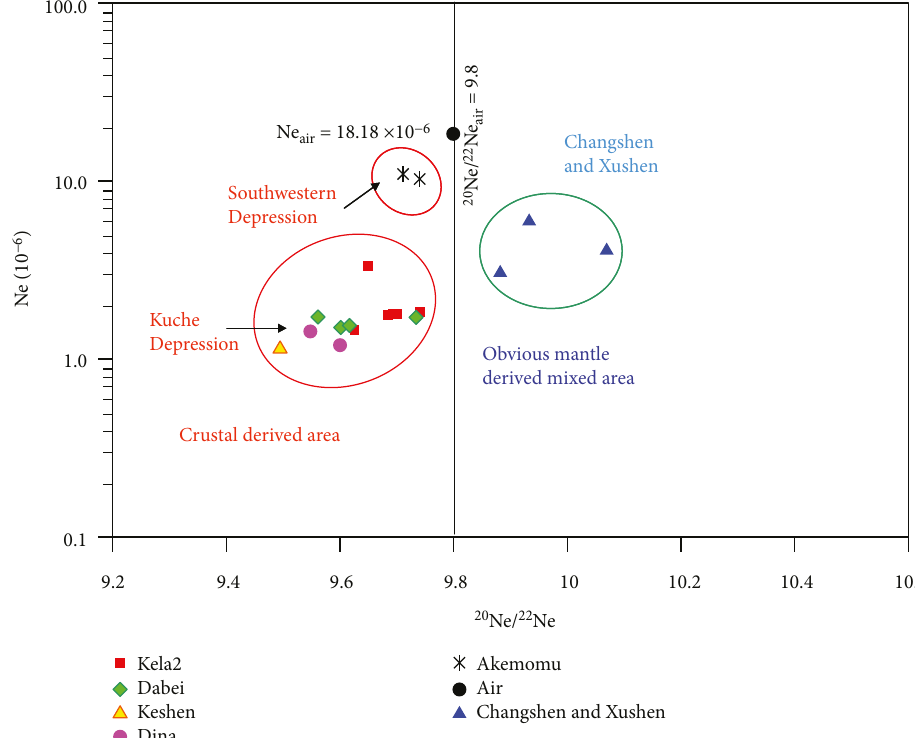
Figure 6: Genetic identi fi cation of Ne- 20 Ne/ 22 Ne for some gas fi elds from the Kuche and Southwestern Depressions, Tarim Basin.